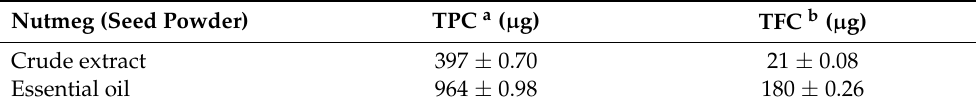
Table 1. The total phenolic and flavonoid contents of crude extract and essential oil. Nutmeg (Seed Powder) TPC a ( µ g) TFC b ( µ g) Crude extract 397 ± 0.70 21 ± 0.08 Essential oil 964 ± 0.98 180 ±